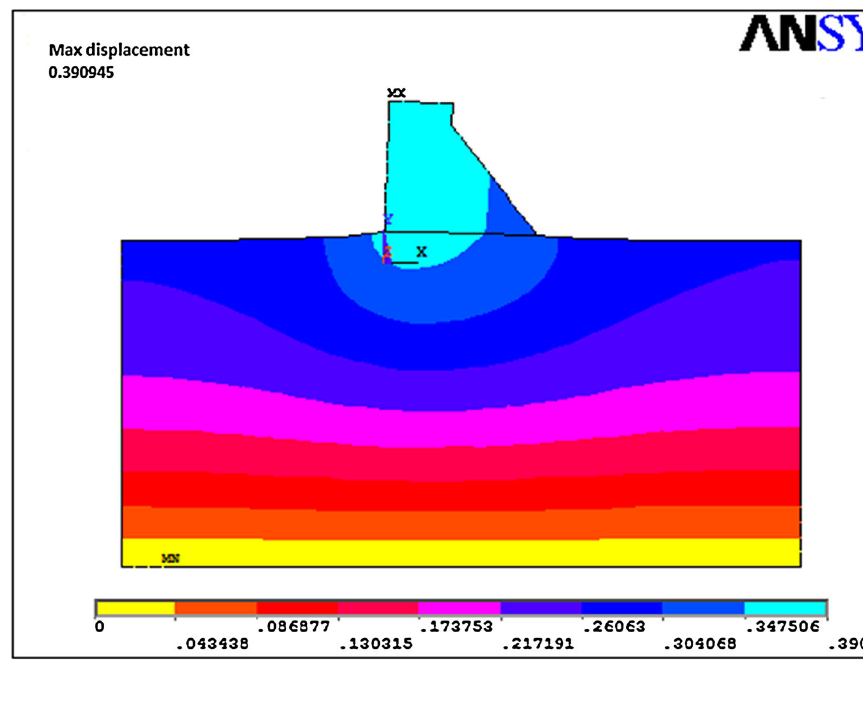
Fig. 7 Constraints (N/m 2 )—